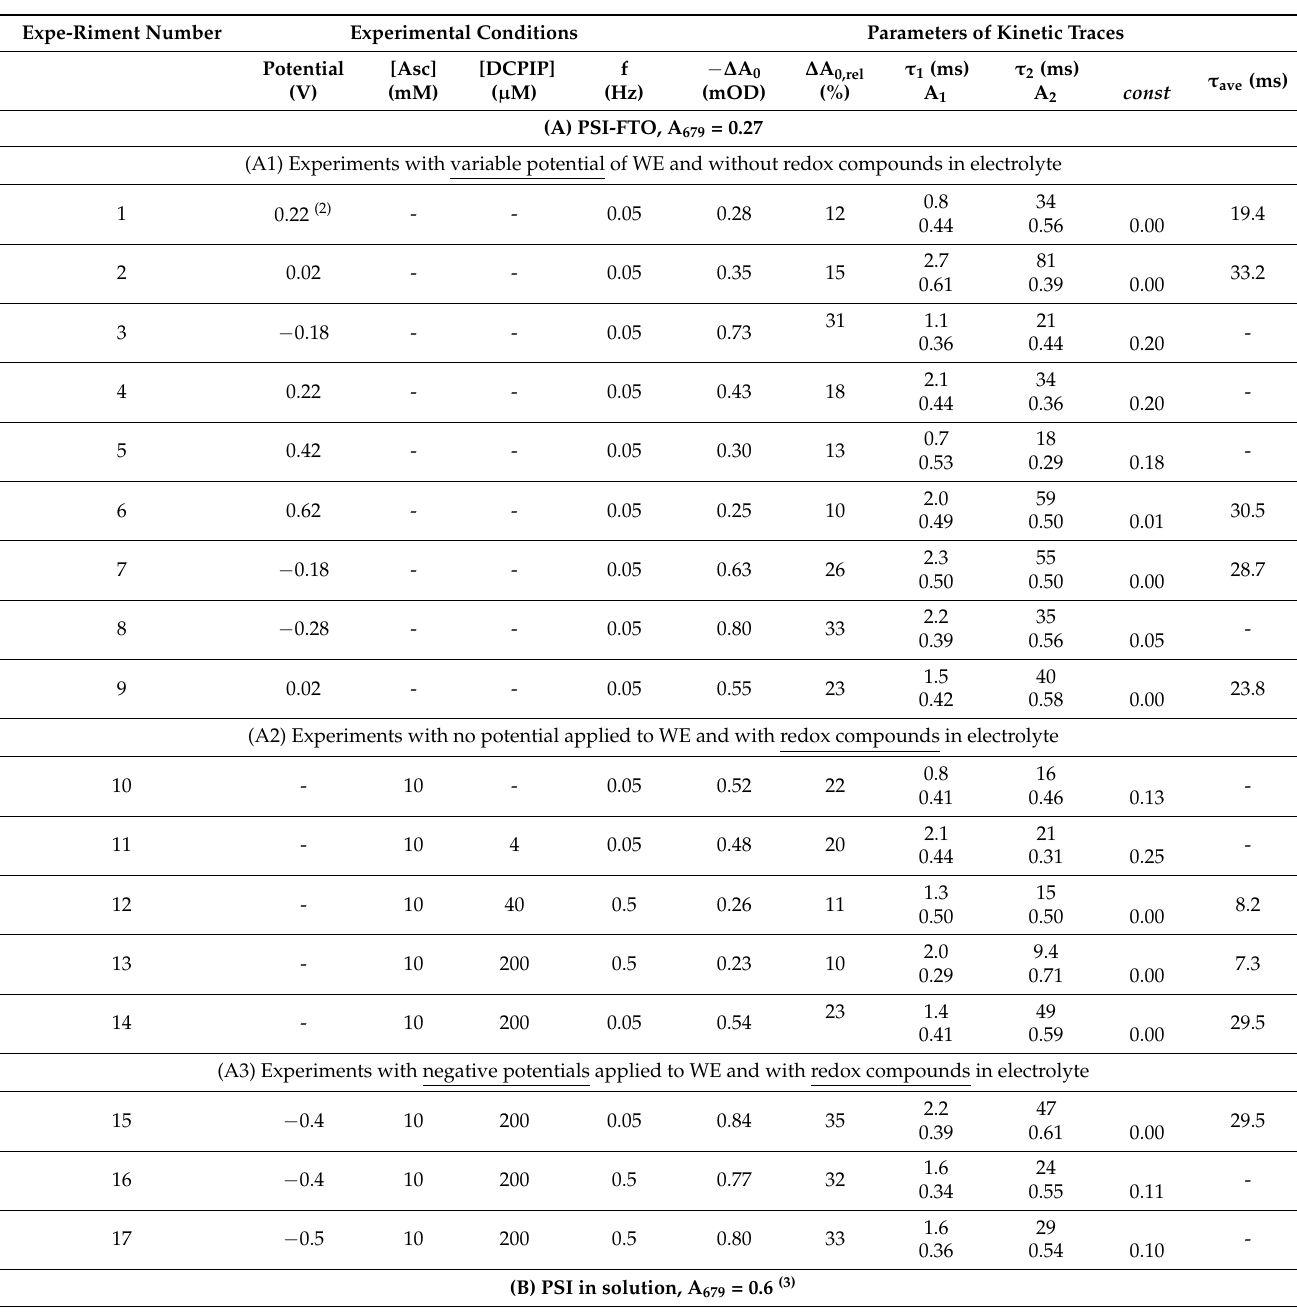
Table 1. Experimental conditions and parameters of transient absorption kinetics of C. merolae PSI complexes recorded at 700 nm. (A) PSI complexes deposited on FTO; (B) PSI suspended in aqueous solution (1)